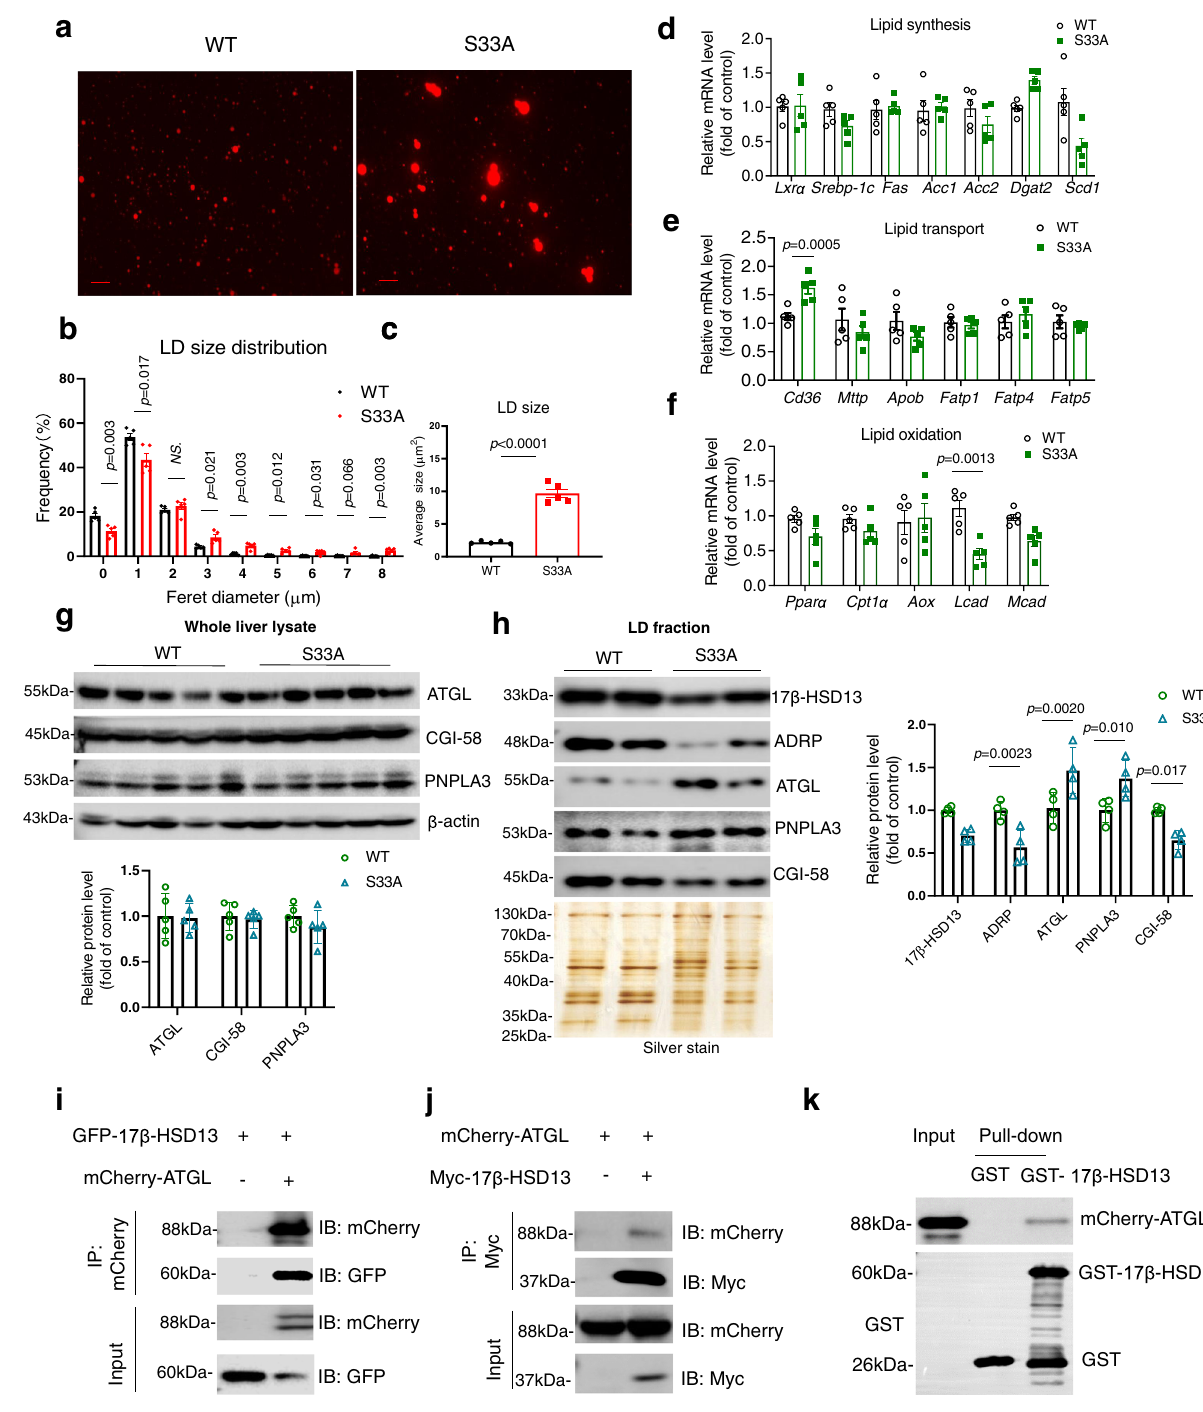
Fig. 4 | 17 β -HSD13 physically interacts with ATGL on lipid droplet. a Repre- sentative Nile red staining of puri fi ed LDs from WT and the S33A mutant mice. LD size distribution ( b ) and average LD size ( c ) were analyzed. WT: n =5; S33A: n =5 biologically independent animals. Quantitative RT-PCR analysis showing